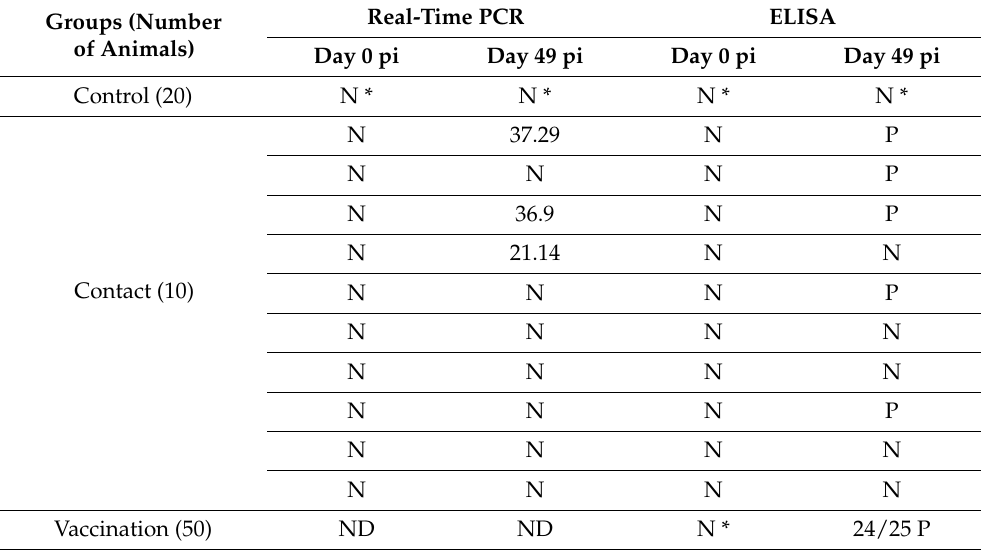
Table 2. Detection of virus genome by PCR (expressed as negative (N) or Ct values (ND: not determined)) and virus-specific antibodies (expressed as negative (N) or positive (P) values) in the blood of control animals or naïve contact animals comingling with IM inoculated with ASFV-G. Groups (Number of